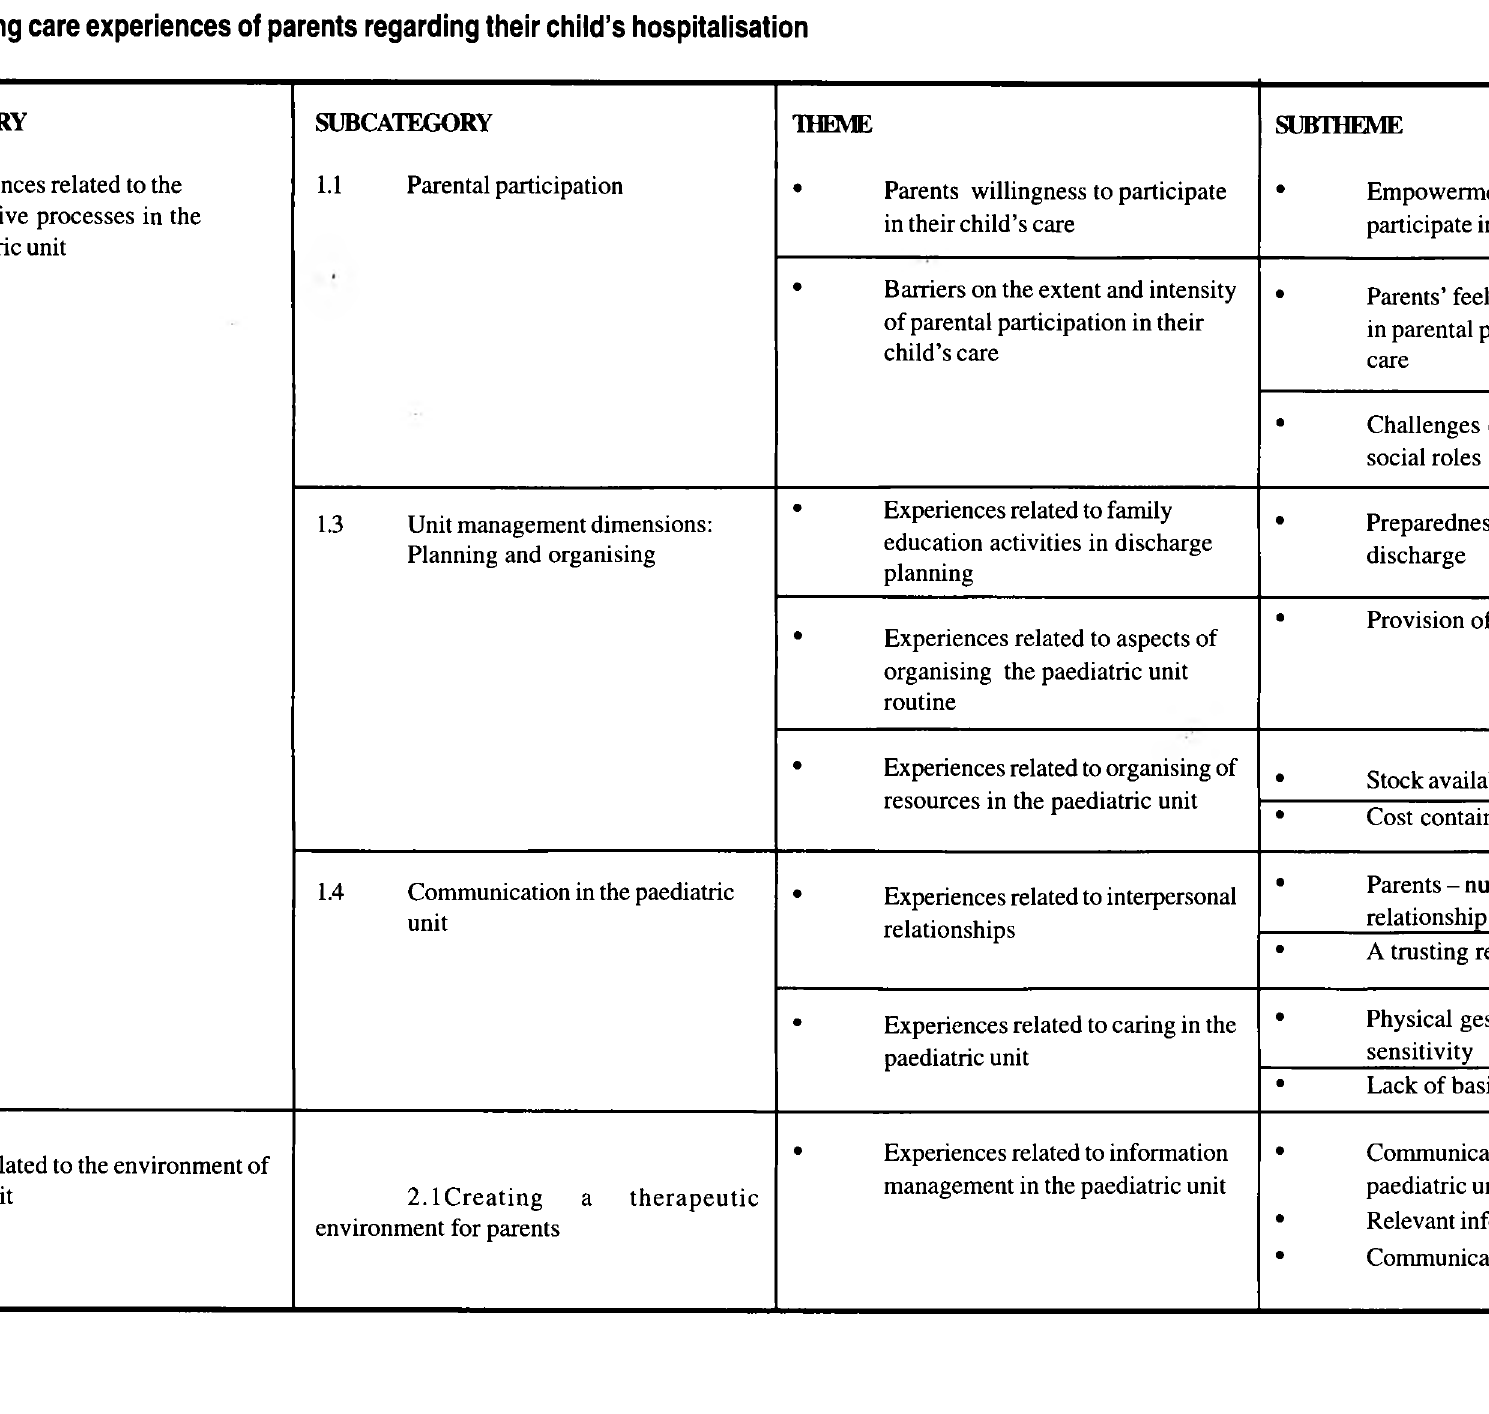
TABLE 1: Nursing care experiences of parents regarding their child’s hospitalisation MAIN CATEGORY 1. Experiences related to the interactive processes in